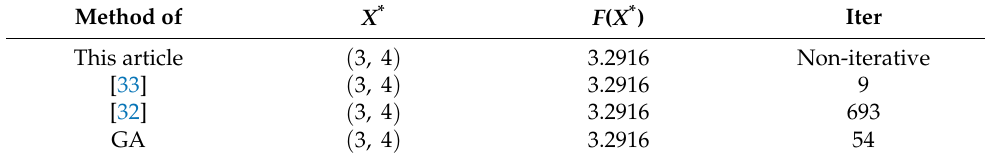
Table 4. Optimal solution and optimal value for (21) obtained by different methods. Method of X * F ( X * ) Iter This article ( 3, 4 )